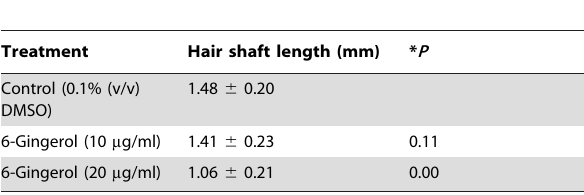
Table 1. Elongation of hair shafts with the indicated treatment